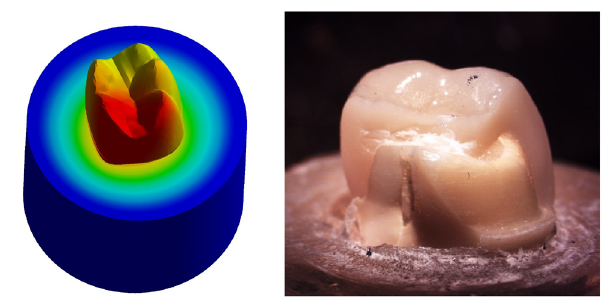
Figure 12. Correlation between total deformation (left) and fracture behavior (right) of Group